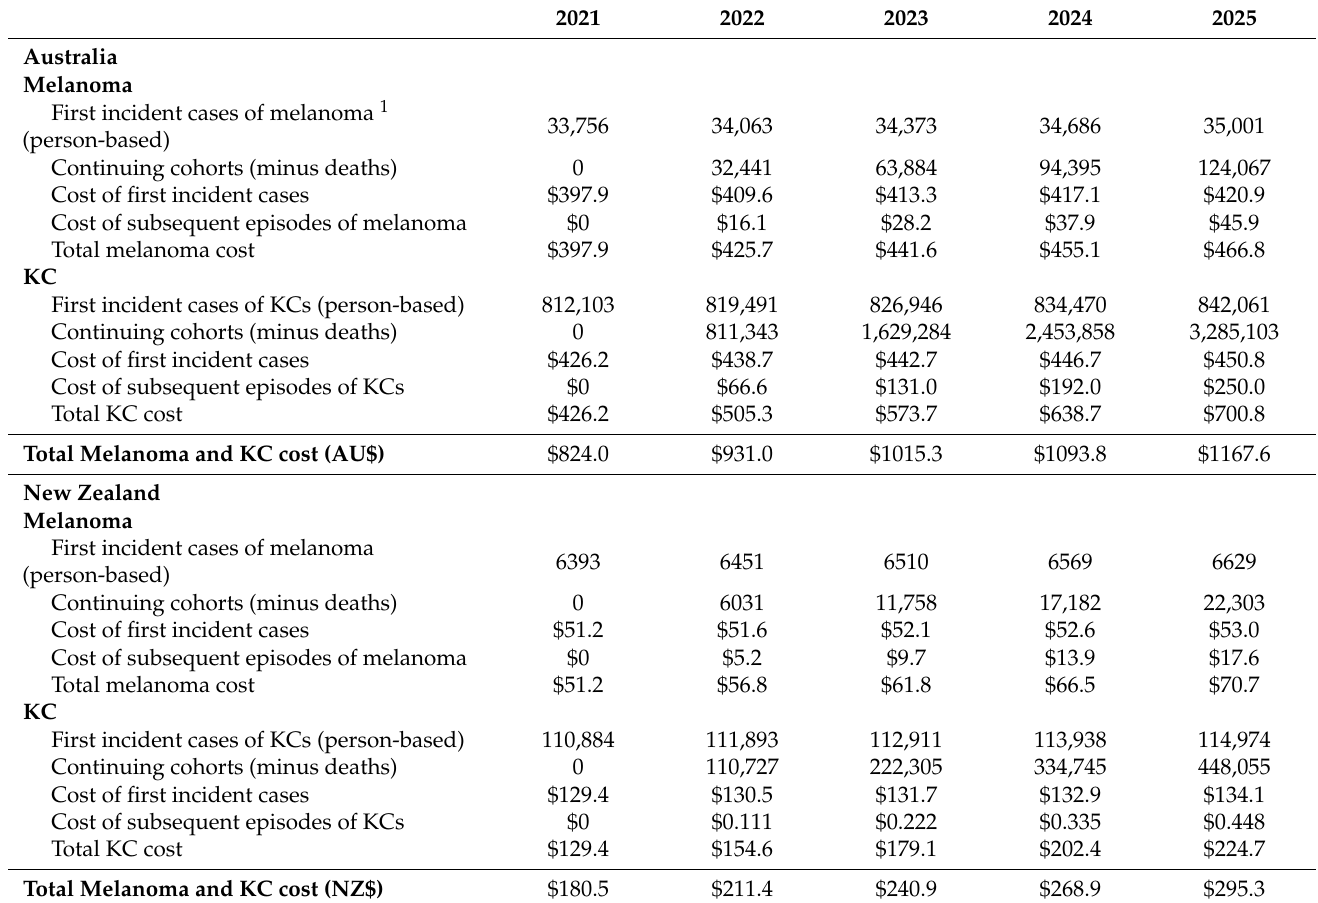
Table 2. Costs of skin cancers in Australia and New Zealand projected over 5 years for new cohorts from 2021. ($